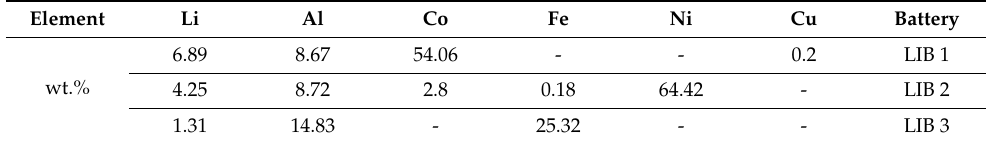
Table 3. Mean content of the main components in the waste cathode material powder ( p = 0.95, n = 4).